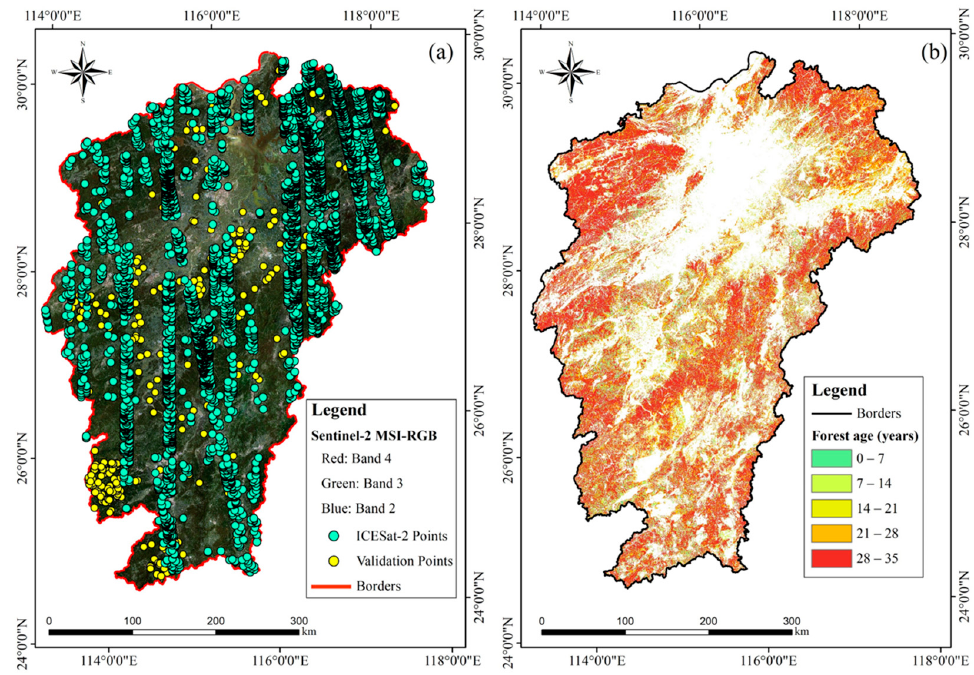
Figure 2. ( a ) Distribution of ICESat ‐ 2 points and field measurements in Sentinel ‐ 2 RGB composite images. ( b ) Forest age of Jiangxi Province. images. ( b ) Forest age of Jiangxi